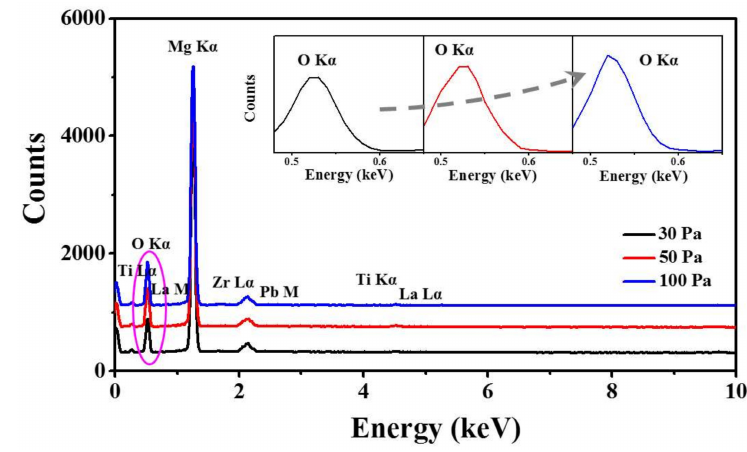
Figure 9. EDS analysis of PLZT thin films by varying the annealing oxygen pressure at 30, 50 and 100 Pa. The inset is the enlarged spectra for O K α peak of each